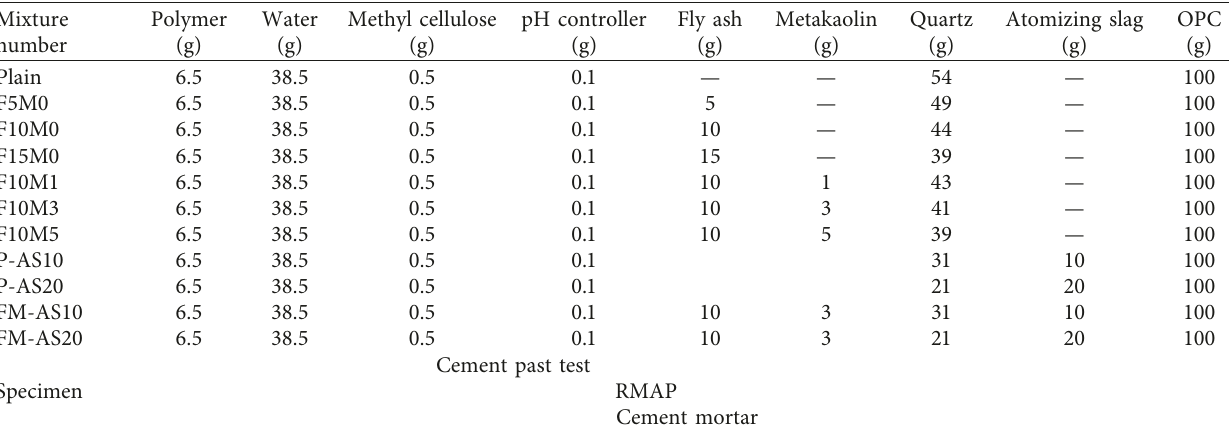
Figure 1: Flowchart of the RMAP mixing process. Table 9: Compositions of the paste and mortar.